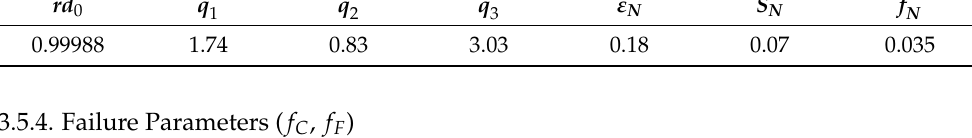
( b ) Figure 15. Major strain predictions of the uniaxial tensile test without the failure parameters: ( a ) regions at the necking and far from the necking and ( b ) corresponding major strain history.